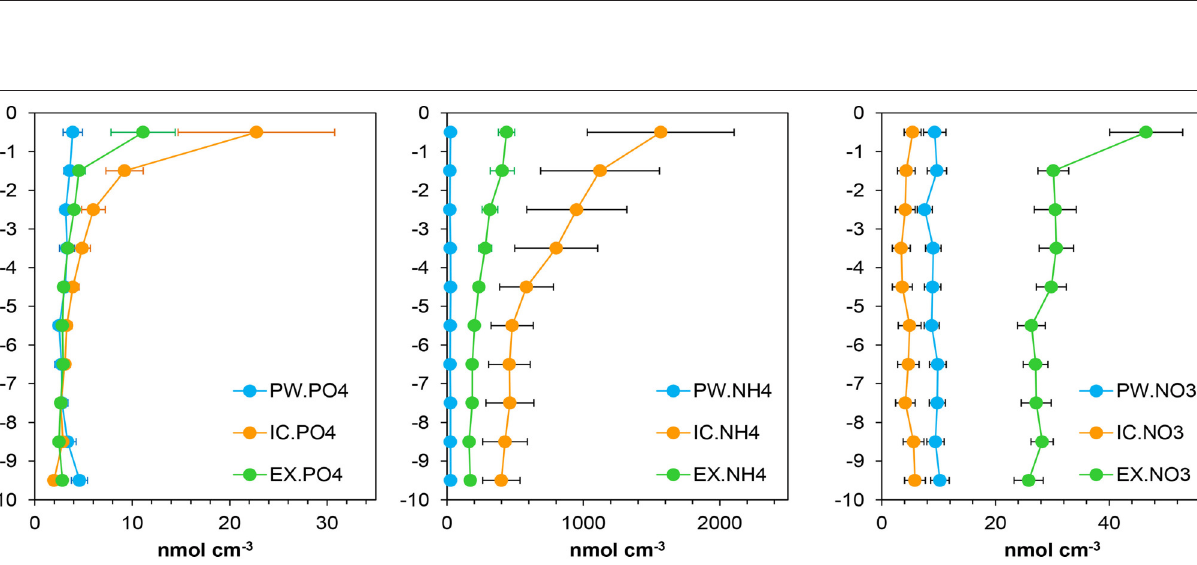
Frontiers in Microbiology |